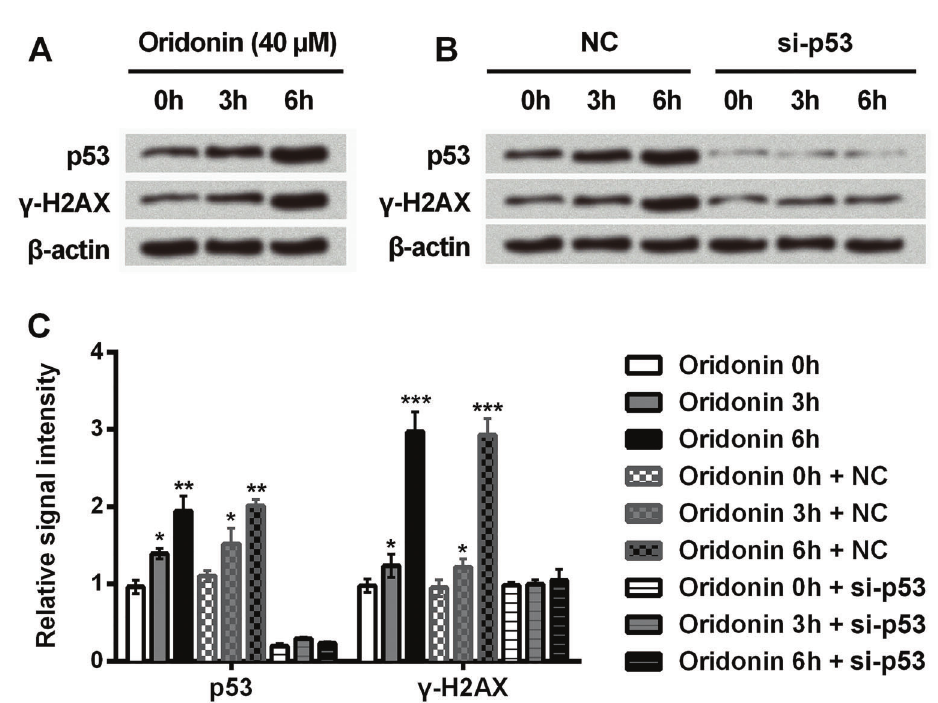
Figure 6. Oridonin induced DNA damage in SNU-216 cells. SNU-216 cells were transfected with si-p53 to silence p53 expression. Then, transfected cells or non-transfected cells were treated with oridonin (40 m M) for 0 h, 3 h, and 6 h. The protein expression of p53 and g -H2AX was measured by western blot. A , Blots of p53 and g -H2AX in non-transfected cells. B , Blots of p53 and g -H2AX in transfected cells. C , Quanti fi cation of relative signal intensity of blots in non-transfected cells and transfected cells. NC, negative control of si-p53. Data are reported as means ± SD. *P o 0.05, **P o 0.01, ***P o 0.001 compared to 0 h